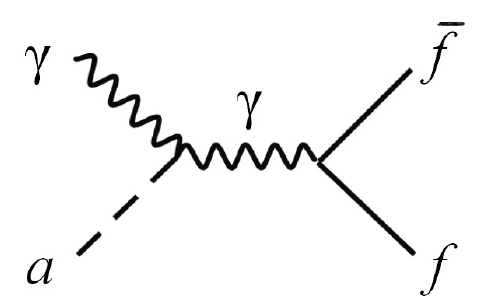
Figure A2. This Feynman diagram represents the a γ → f f scattering in the s -channel and the af → γ f scattering in the u -channel.